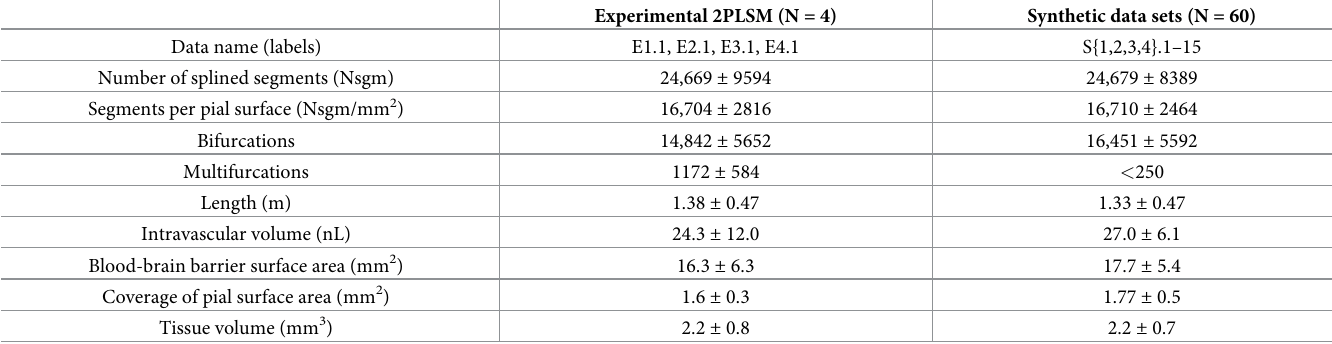
Table 1. Topological feature comparison between experimental 2PLSM and synthetic data